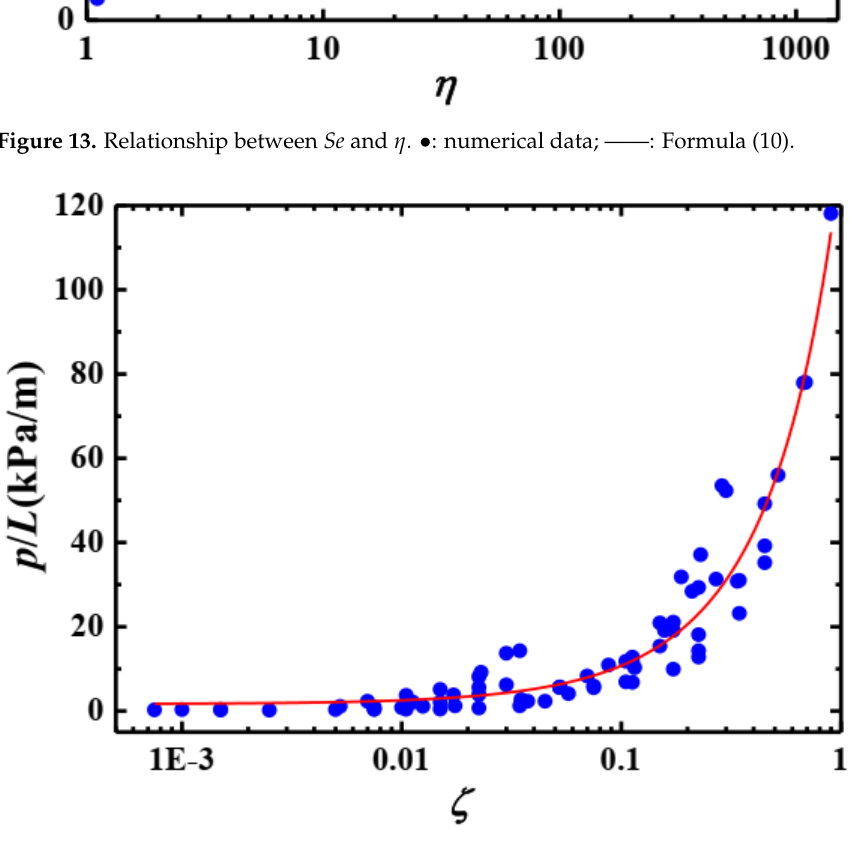
Figure 14. Relationship between Se and ζ . • : numerical data; ——: Formula